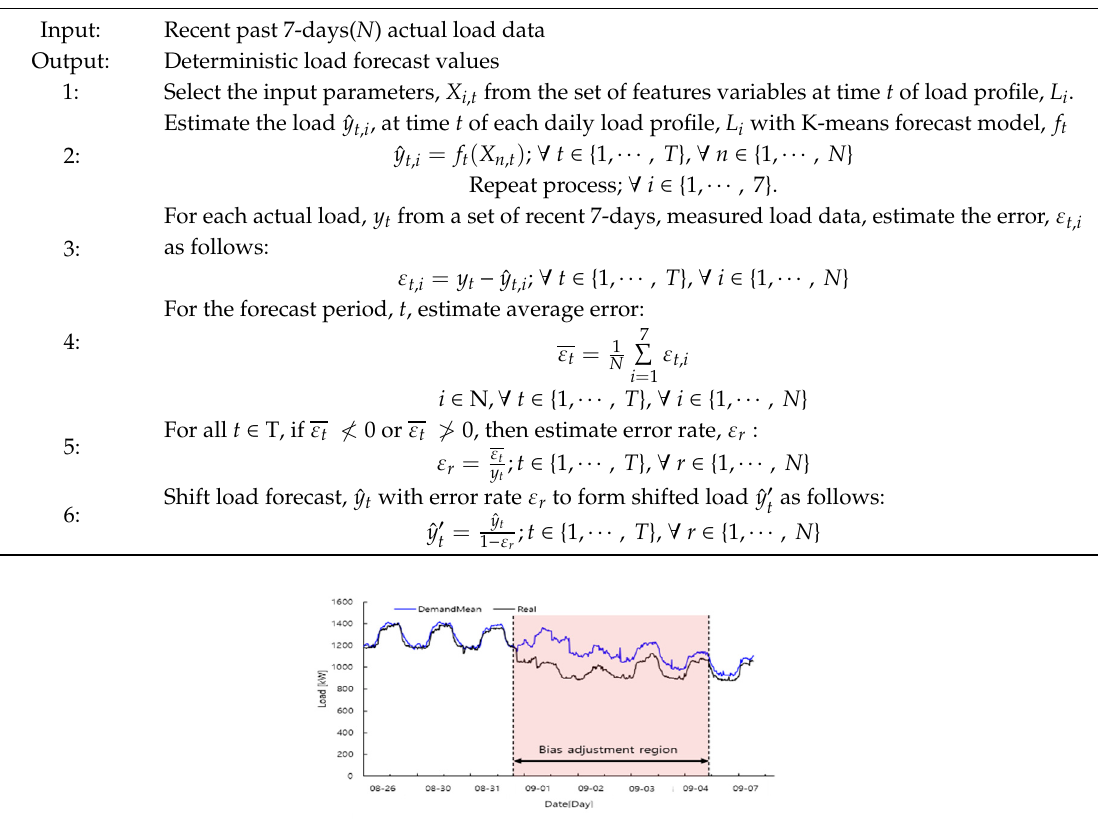
Algorithm 3: Permanent Bias Error Correction Model.